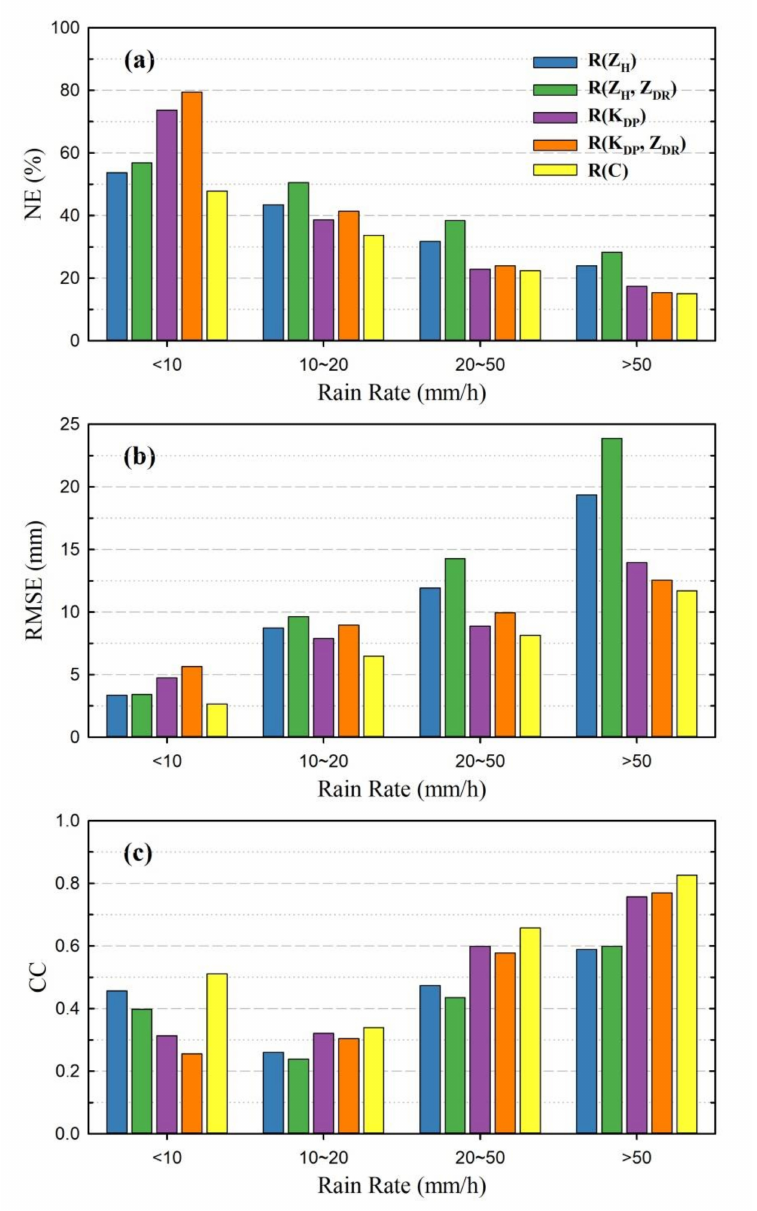
Figure 7. Bar graphs showing ( a ) NE (%), ( b ) RMSE (mm/h) and ( c ) CC(non-dimensional) obtained from rainfall estimator of R(Z H ), R(Z H , Z DR ), R(K DP ), R(K DP , Z DR ) and R(C) for different hourly accumulation classes in all eight rainfall